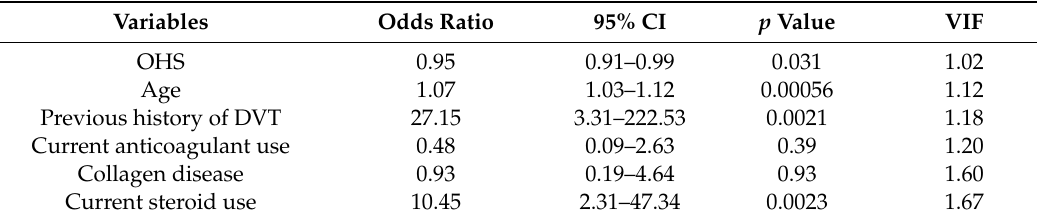
Table 6. Multivariate logistic regression analysis using two parameters reaching p < 0.05 in univariate testing with OHS as a representative clinical measurement.